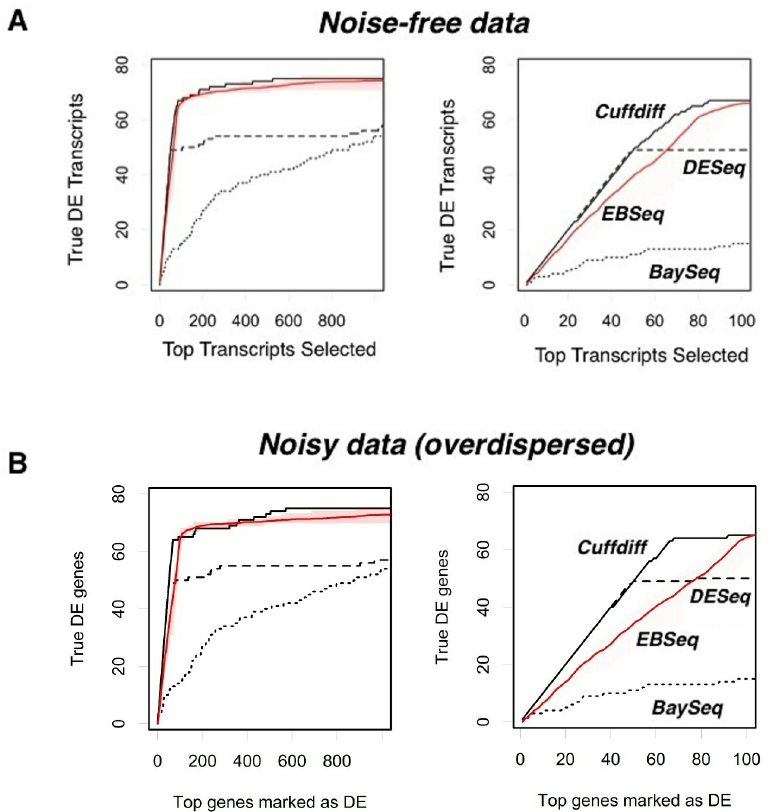
Figure 4. Comparison of true discovery rates for various RNA-Seq differential expression testing methods. The test data sets were generated and various software suites implemented, as described in Methods. Each panel contains two plots; the plot on the right is a zoomed-in version of the plot on the left. On the y-axis is the number of correctly-identified transcripts, and on the x-axis is the number of transcripts selected (in order of increasing p -value). DE stands for differentially expressed. In every plot, the thick black line corresponds to Cufflinks, the thick red line to R-EBSeq, the large-dashed black line to DESeq and the small-dashed black line to BaySeq. These lines are also labeled as indicated. The shaded region surrounding the R-EBSeq curve depicts the range of 20 independent runs. ( A ) Performance of the various methods with noise-free data; ( B ) Performance of the various methods with noisy data. Noise was added as described in Methods, and the data are overdispersed, as typical for RNA-seq